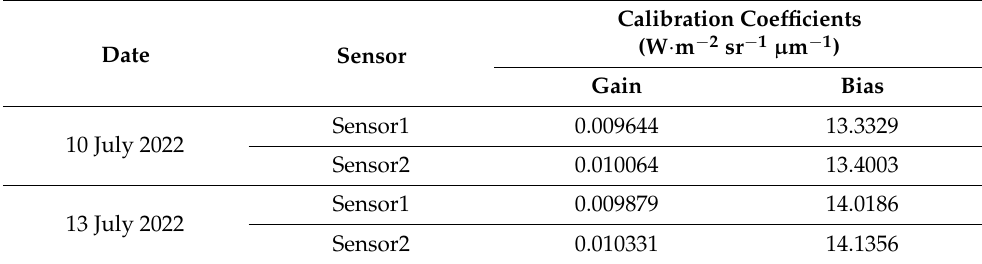
Table 3. IRS radiometric calibration